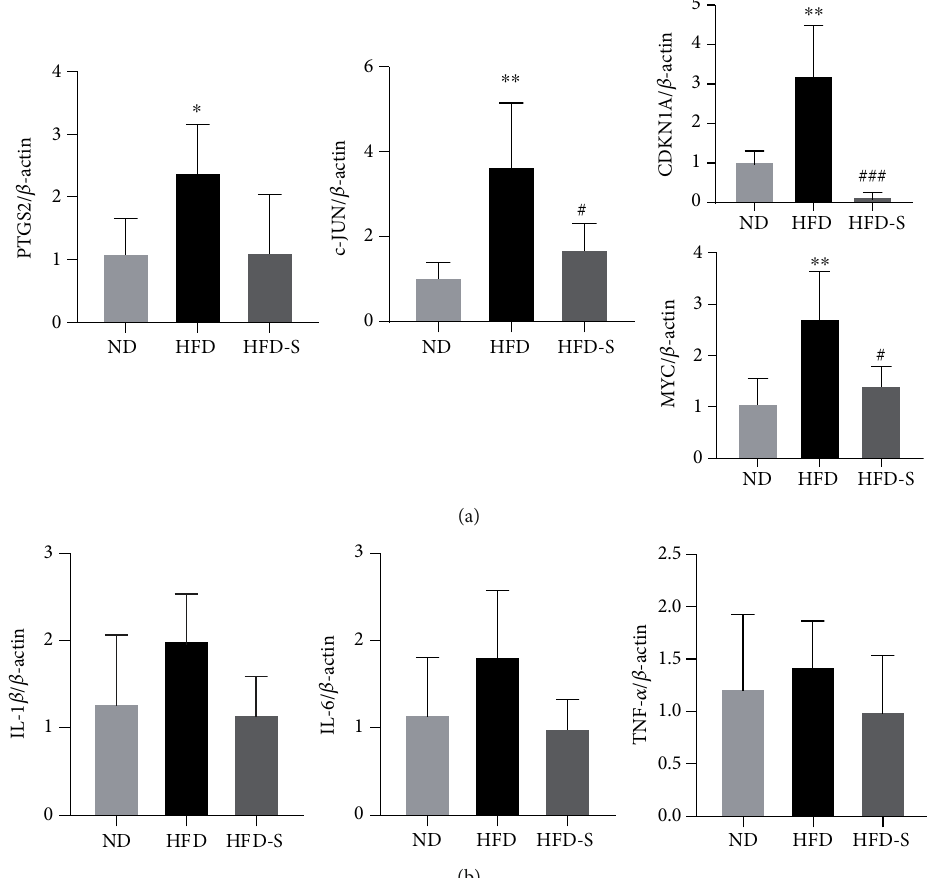
Figure 12: qRT – PCR results ( n = 5 , mean ± SD ). (a) The RNA level of hub target genes. (b) The RNA levels of in fl ammatory cytokines. ∗ p < 0 : 05 , ∗∗ p < 0 : 01 vs. ND; # p < 0 : 05 , ### p < 0 : 001 vs.